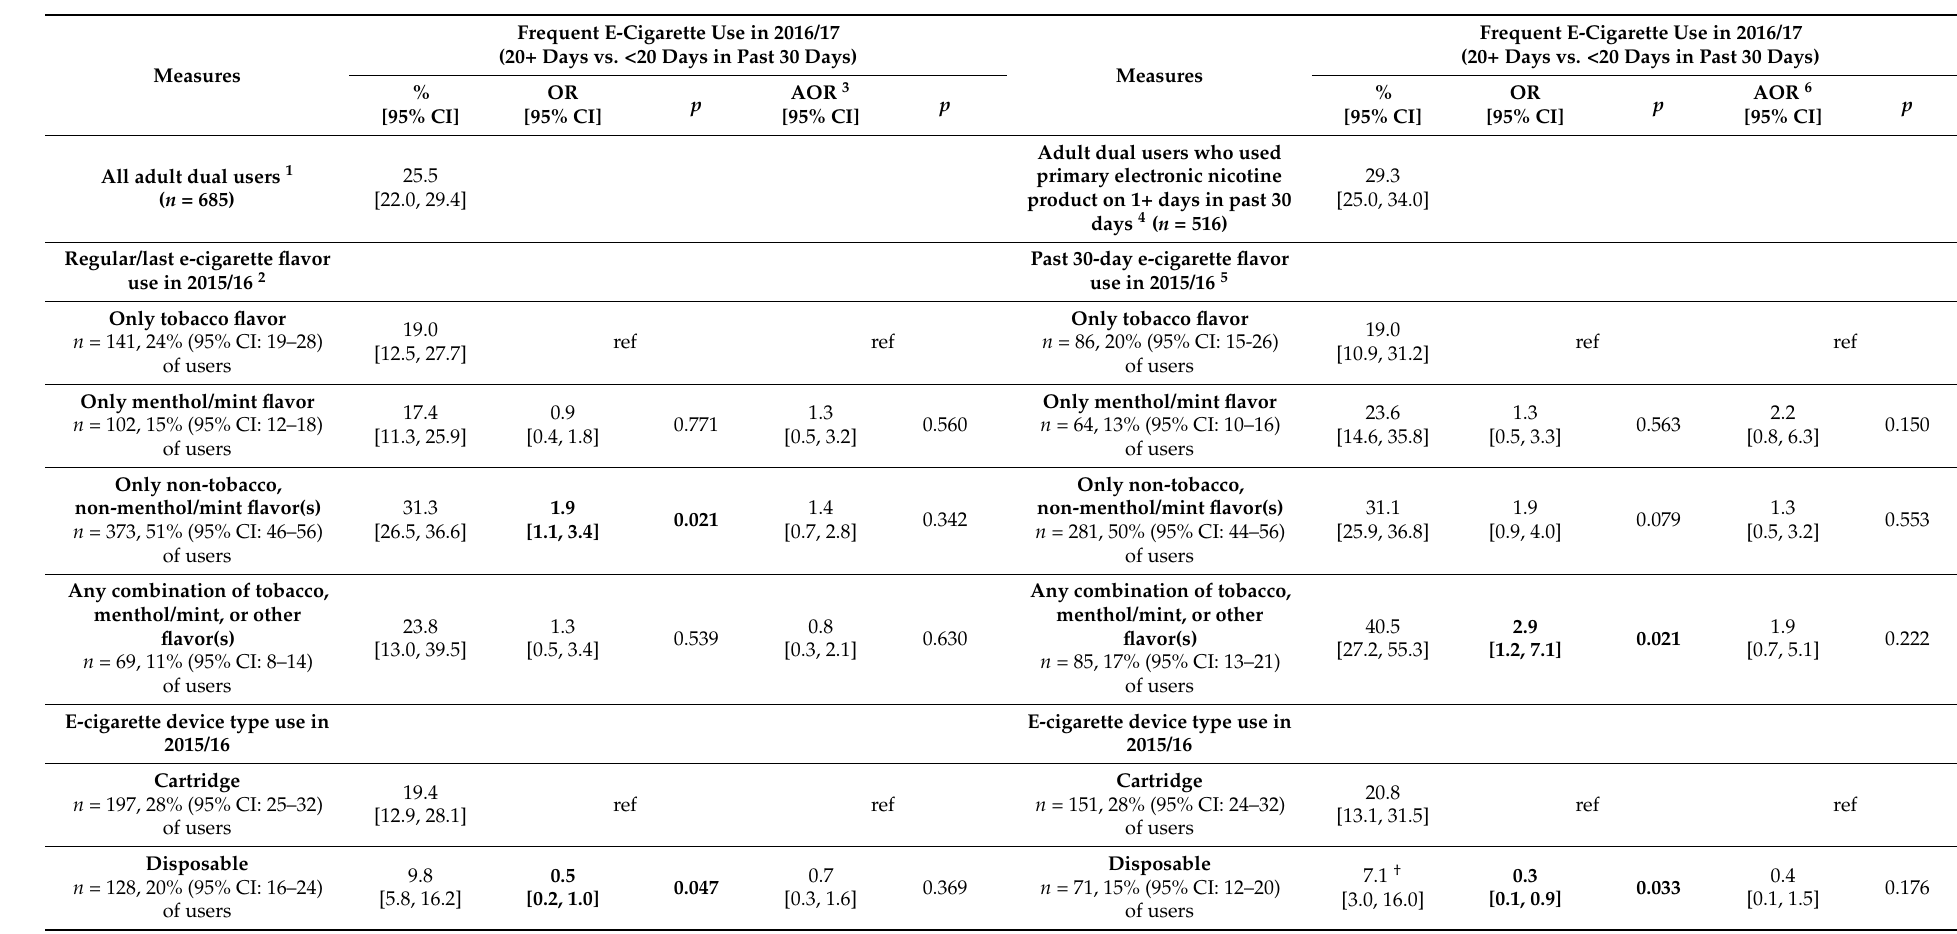
Table 2. Frequent e-cigarette use in 2016/17 by e-cigarette flavor and e-cigarette device type use in 2015/16 among adult dual users who attempted to quit smoking between 2015/16 and